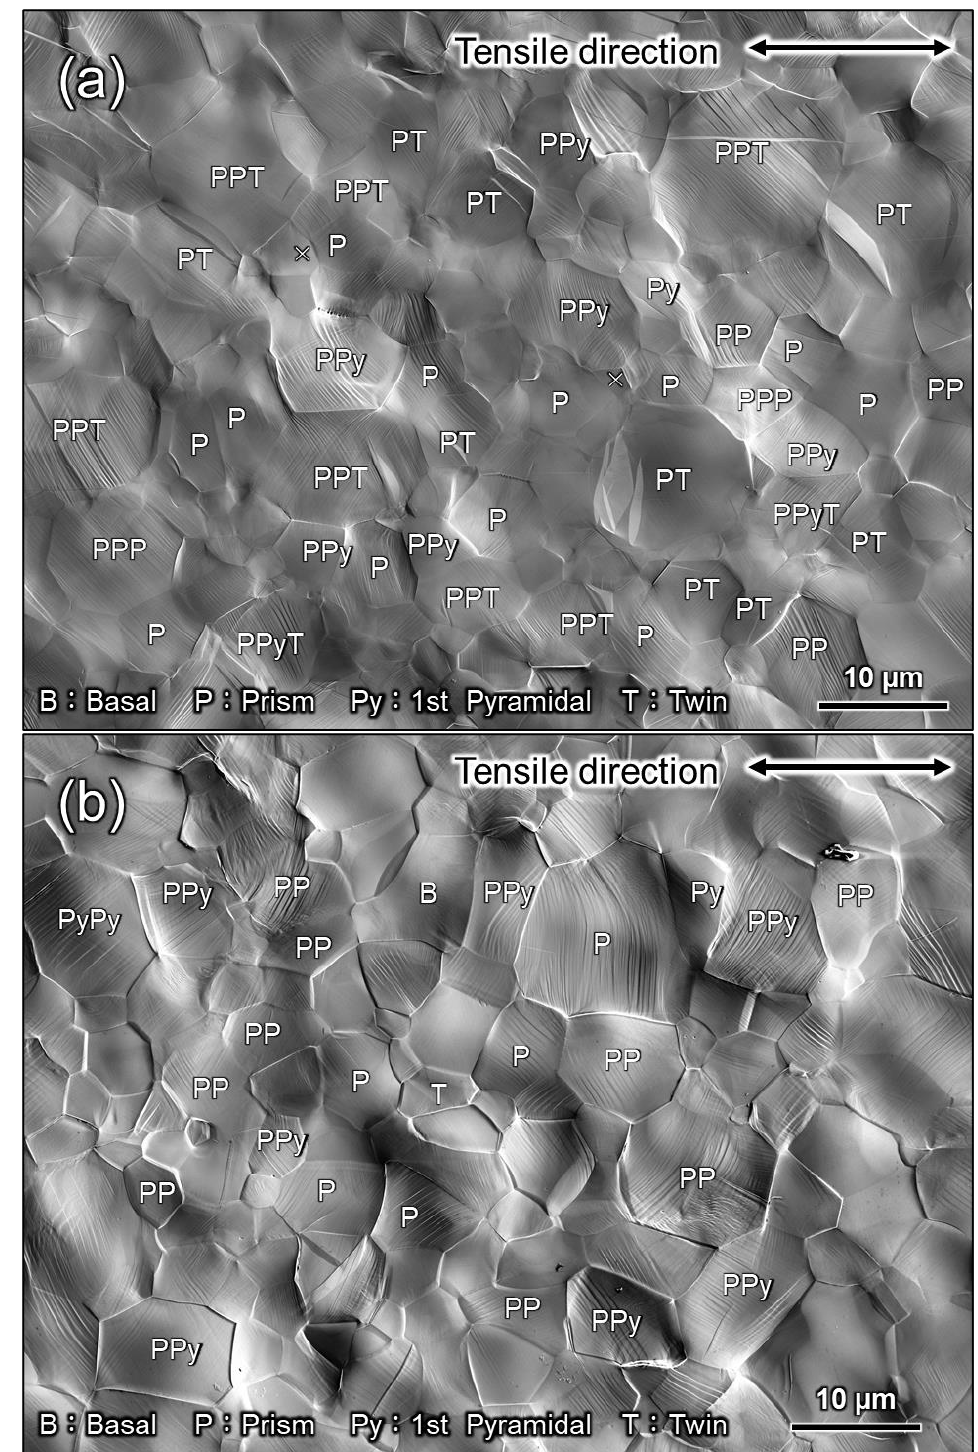
Figure 10. SEM images of Ti-30 after deformation by approximately 15% plastic strain at ( a ) high (10 0 s −1 ) and ( b ) low (10 −6 s −1 ) strain rates. B , P , Py , and T indicate that the basal slip, prism slip, 1st order pyramidal slip, and twinning were active, respectively.